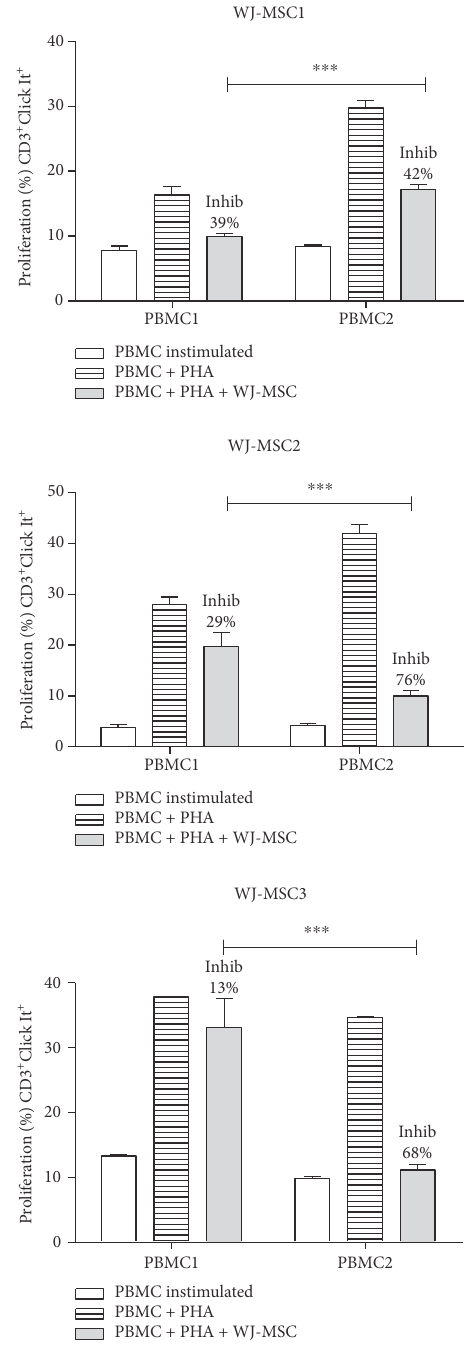
Figure 2: WJ-MSC inhibit CD3 + T cell proliferation. WJ-MSC were seeded, after 24 hours. PBMC were added and stimulated with PHA for 3 days in the presence of MSC; the ratio used was 1 :10 (WJ- MSC : PBMC). The WJ-MSC passages used in experiments were either P5 or P6. T cells were collected and stained with anti- CD3 antibody and proliferation measured by fl ow cytometry using the Click It Kit. The percentage of inhibition (Inhib) was calculated using the percentage of proliferation of PBMC + PHA+ WJ-MSC compared to the control PBMC + PHA. Experiments were performed in triplicate. Results are represented by mean ± SD. Statistically signi fi cant di ff erences are shown as ∗∗∗ p < 0 0001 ( n = 3